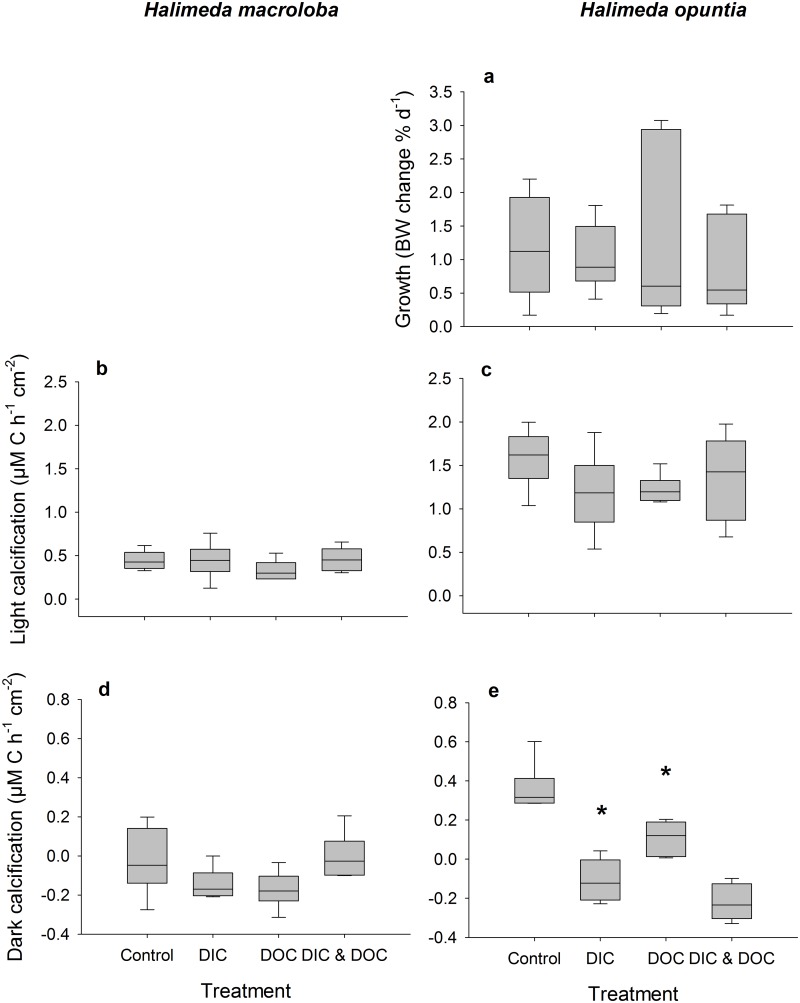
Growth parameters as treatment response after experimental duration of 16 d.Treatments were controls (ambient DIC and DOC), DIC (high DIC and ambient DOC), DOC (ambient DIC and high DOC) and DIC &DOC. Growth is expressed as % change of buoyant weight (a) of Halimeda opuntia (n = 6). Calcification during light (b, c; 150 μE m-2 s-1) and dark condition (d, e) of Halimeda macroloba (b, d, n = 6) and Halimeda opuntia (c, e, n = 6) measured via alkalinity anomaly technique and standardized to surface area. Significant differences compared to controls (p < 0.05) are marked with an asterisk. Box plots show the median as well as the upper and lower quartile. Whiskers indicate the 95 percentile.